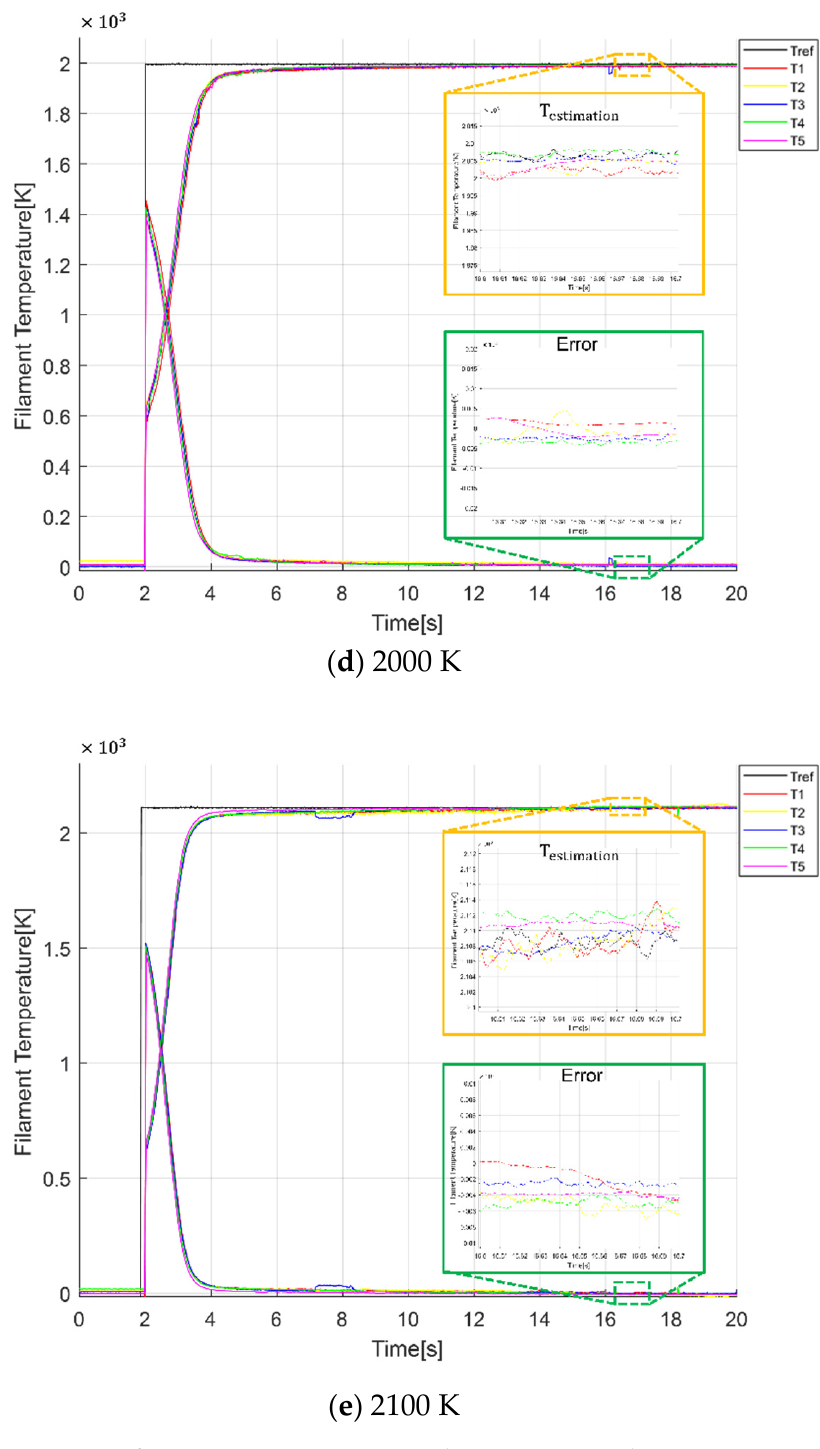
Figure 9. Reference temperature, estimated temperature, and temperature error waveforms for temperature references of ( a ) 1700 K, ( b ) 1800 K, ( c ) 1900 K, ( d ) 2000 K and ( e ) 2100 K. Table 2. Comparison of the temperature controller accuracy for different temperature references.